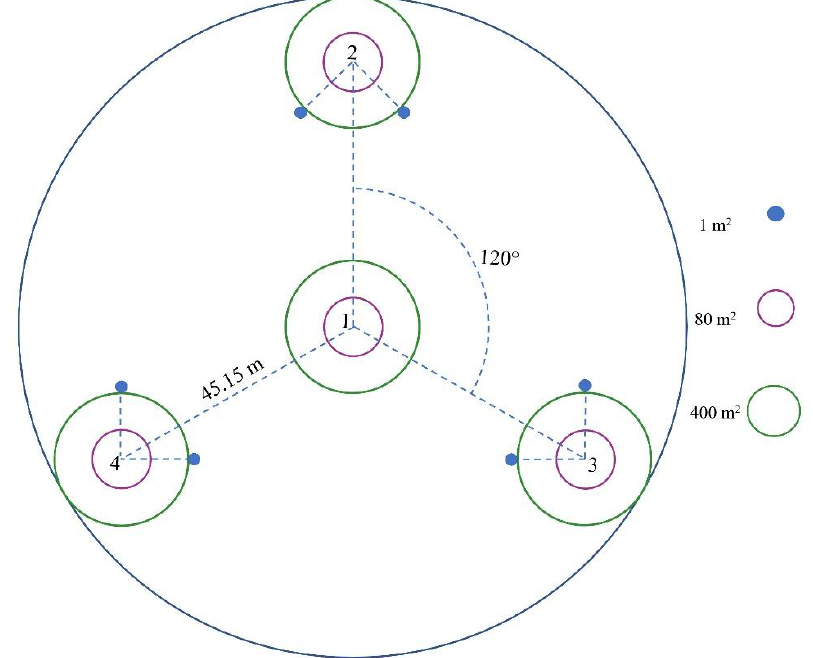
Figure 2. Plot design used for forest measurement. Plot design is composed of four grouped circular subplots. Subplot 1 is the center of the cluster, with the other three plots located 45.15 m away at azimuths of 360 ◦ , 120 ◦ , and 240 ◦ , respectively. Understory biomass was sampled at 1 m 2 microplots, tress with DBH ≤ 2.5 were sampled in a central circular plot of 80 m 2 , and trees with DBH ≥ 5 cm were measured in the circular plot of 400 m 2 . 1 m 2 microplots are not to scale.